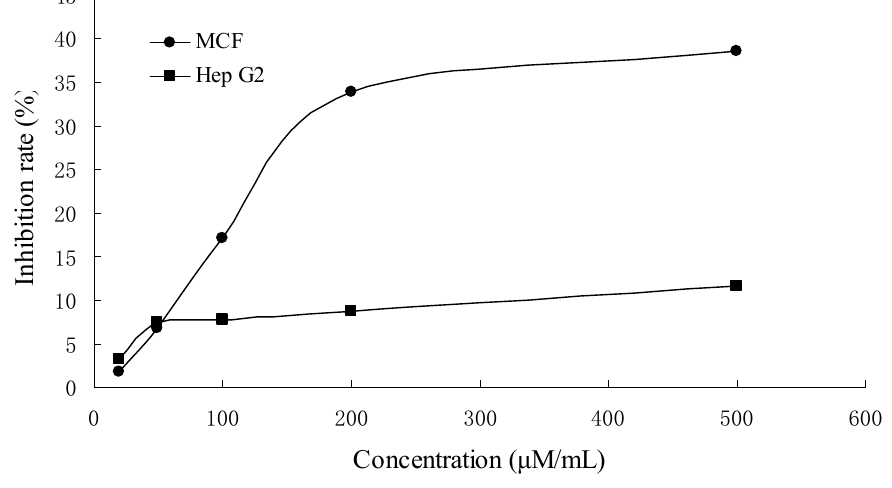
Figure 5. Effect of camellianin A on Hep G2 and MCF-7 cell proliferation.